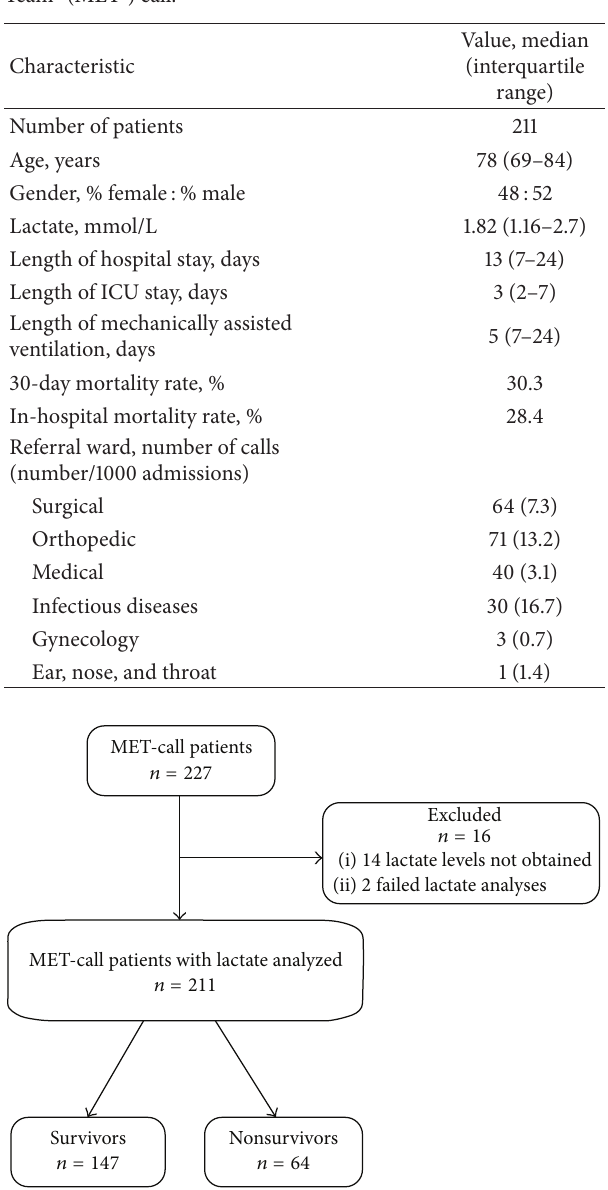
Figure 1: Enrolment and outcomes of study patients (MET: Medical Emergency